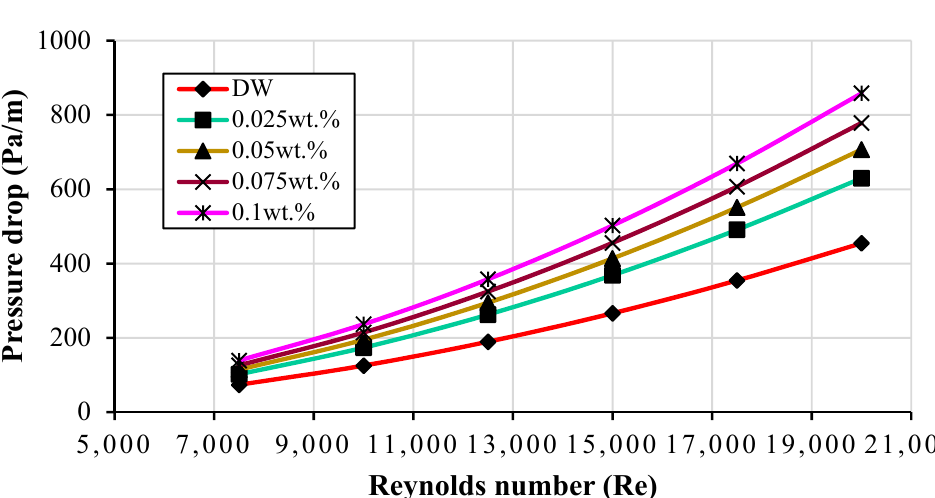
Figure 8. The frictional pressure loss of DW and different mass fractions of CF-GNPs versus different Reynolds numbers. Table 2. Experimental and numerical studies on the use of carbon nanostructured nanofluids in heated pipe.